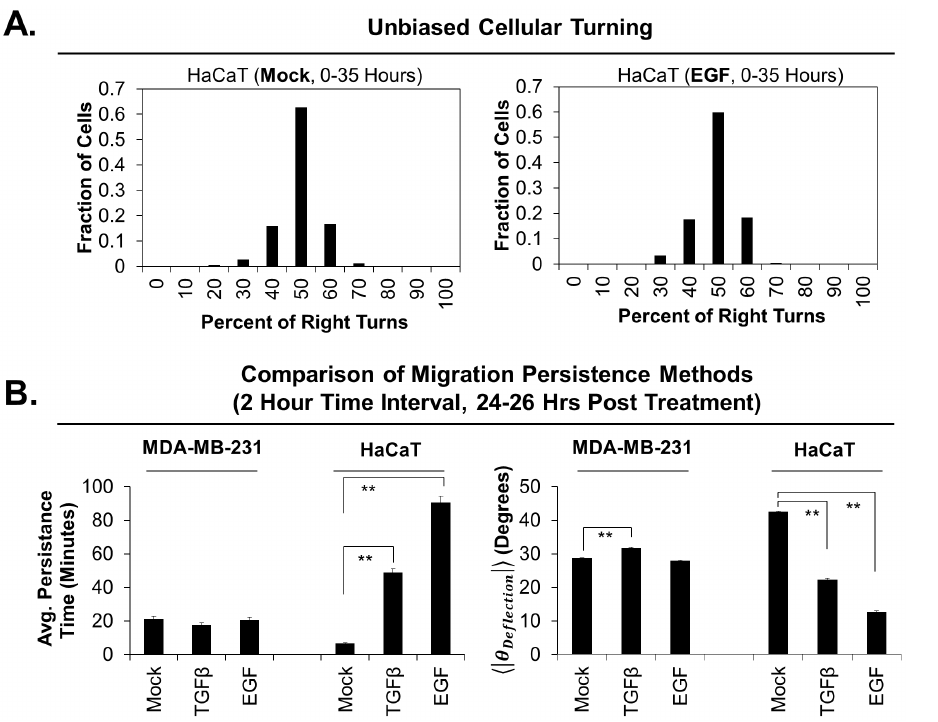
Figure 3. Average absolute angle of deflection measurements accurately depict the migration persistence of cells. A ) Cells do not prefer to turn right or left in either the presence (right) or absence (left) of EGF stimulation. A binned histogram of percent of cells versus percent of right turns is normal and centered around 50 percent. B ) A comparison of persistence time calculations and average absolute angle of deflection ( SD h Deflection DT ) methods for measuring migration persistence yields identical trends in both the presence and absence of either TGF b or EGF for MDA- MB-231 cells and HaCaT cells. Double asterisks indicate a p value , 0.01. Each condition represents greater than 200 cells for persistence time measurements, and greater than 1000 cells for average absolute angle of deflection